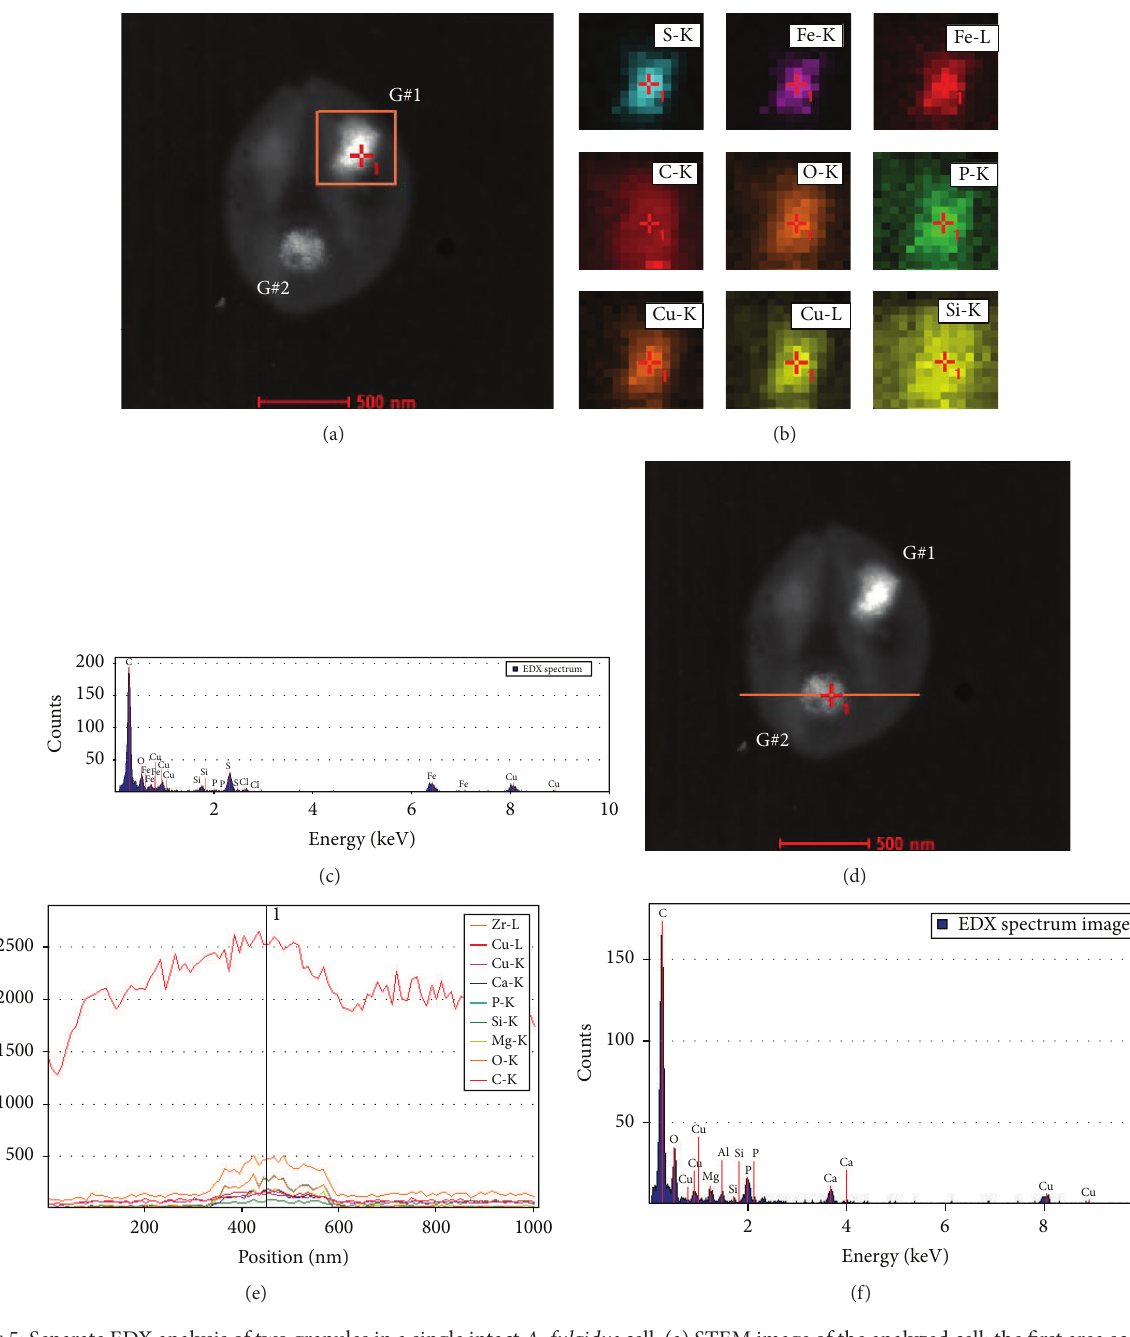
Figure 5: Separate EDX analysis of two granules in a single intact A. fulgidus cell. (a) STEM image of the analyzed cell; the first area scanned by the probe is shown as an orange box. The two granules are labeled as G#1 and G#2. (b) The EDX area scans for each element found in the region specified in (a), which contains G#1. Each element is plotted in a different color. (c) The individual EDX point spectrum from the location specified in (a) and (b) by a cross with the number 1. (d) STEM image of the analyzed cell; the path of the probe for the second scan is shown as an orange line. (e) The EDX line spectra across the cell shown in (d), which contains G#2. Each element is plotted in a different color. (f) The individual EDX point spectrum from the location specified in (d) by a cross with the number 1 and in (e) by a vertical